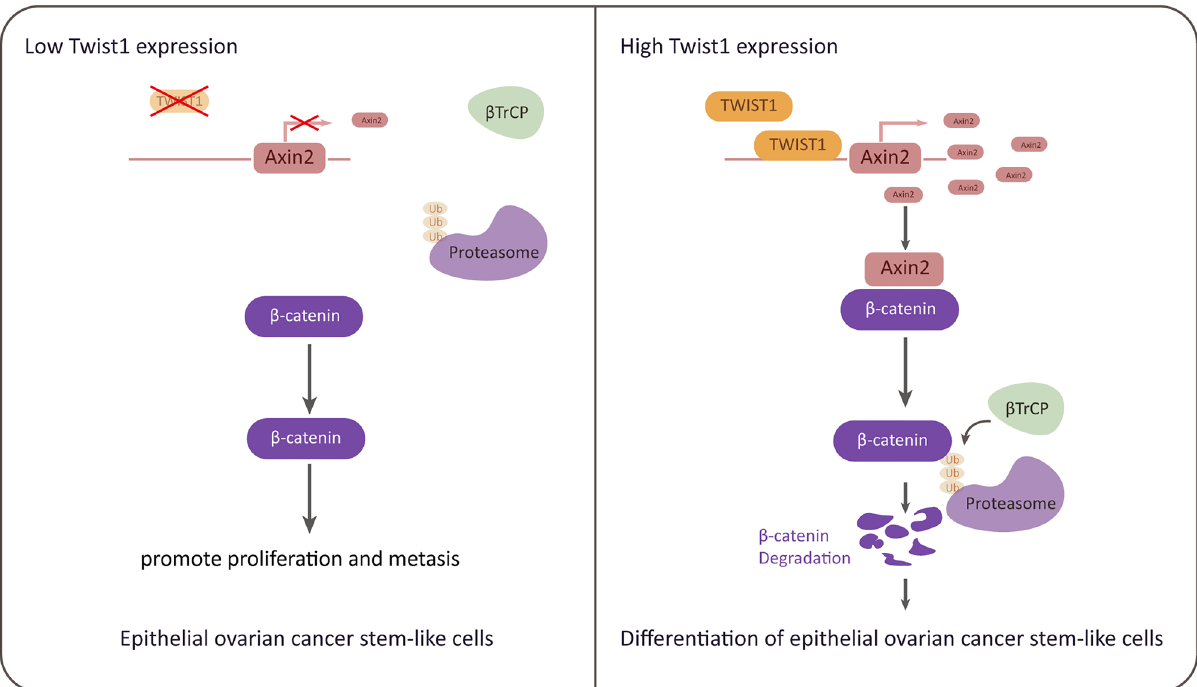
Figure 6. Working model of TWIST1